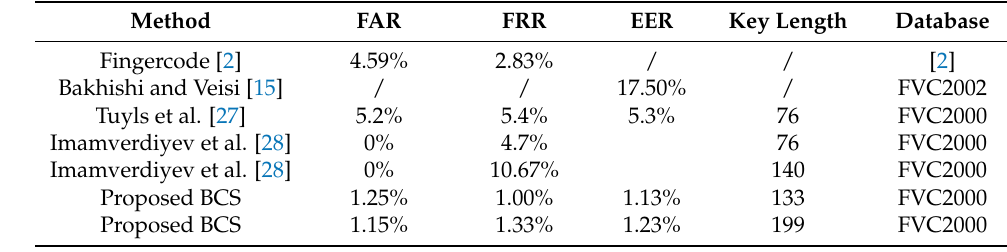
Table 3. Comparative